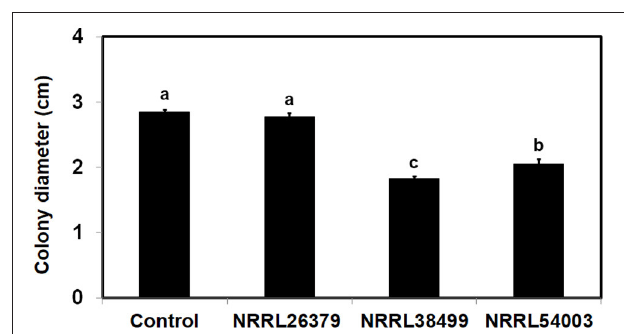
FIGURE 6 | Effect of F. oxysporum VCs on the amount/activity of antifungal metabolites secreted by T. harzianum . T. harzianum strain isolated from Custom GP was exposed to VCs from three F. oxysporum strains and un-inoculated PDA (Control) for 33h. After removing the cellophane membrane along with T. harzianum culture, one plug of NRRL54003 culture was inoculated on each plate. Colony diameters after 3 days of incubation are shown. Values shown correspond to the mean SD of data from three ± replicates. Different letters indicate significant differences based on Fisher’s test at P 0.05. =